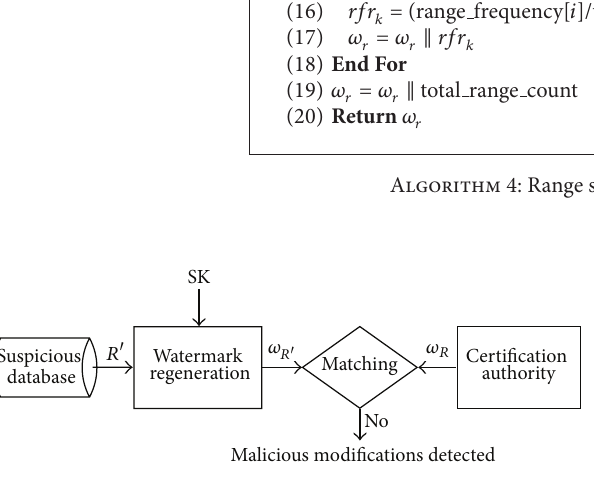
Figure 2: Proposed model for detection of malicious